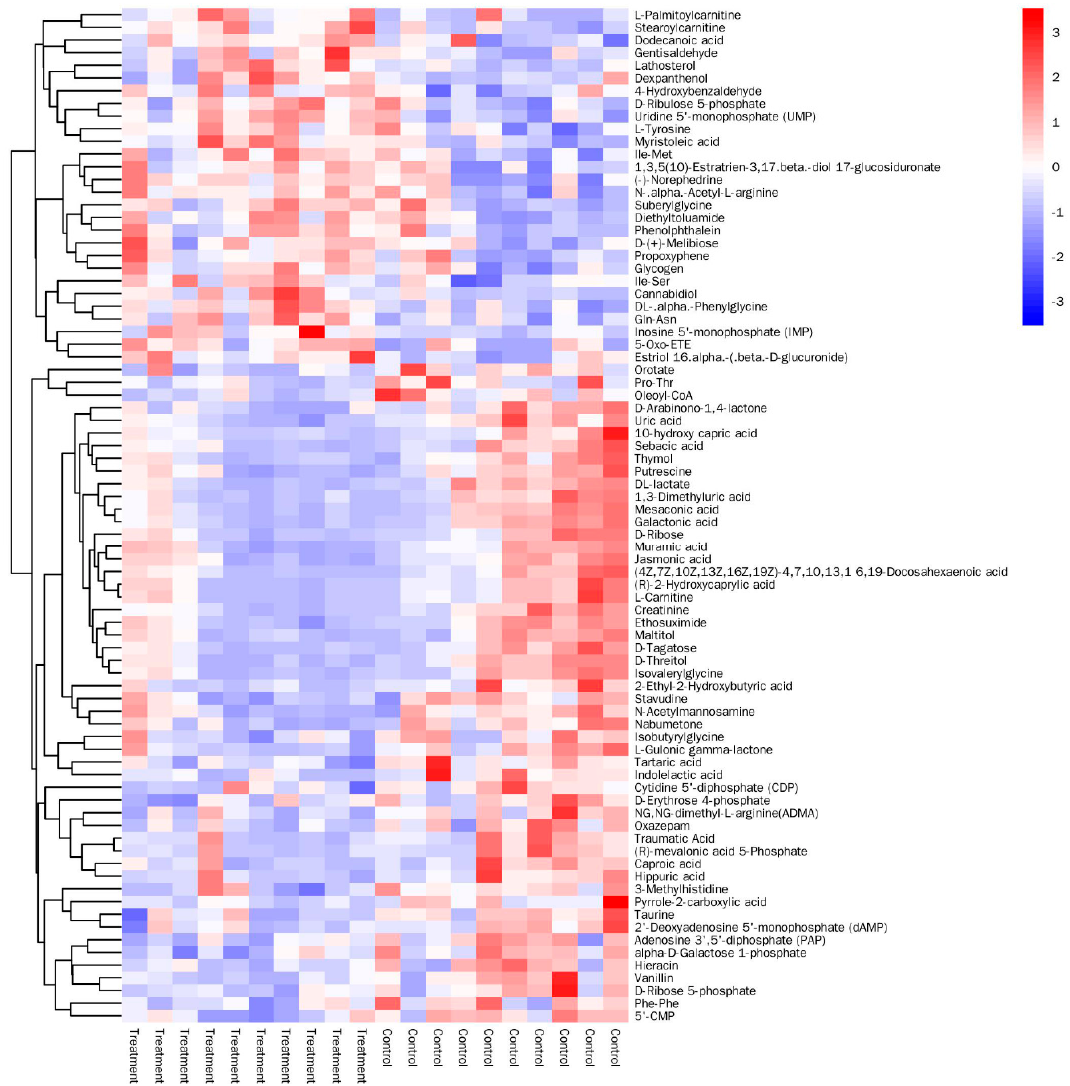
Figure 3. Heat map visualization for significantly differential metabolites identified in gut tissues between A. apis -infected larvae and controls. Colors indicate the relative level of metabolites in the samples, ranging from highest (red) to lowest (blue): red indicates a relatively higher level, blue indicates a relatively lower level and white indicates the relative level of metabolites falls between high and low. Table 1. A list of 30 significant differential metabolites with the highest fold difference in guts between A. apis -infected larvae and controls with VIP > 1 and p < 0.05.